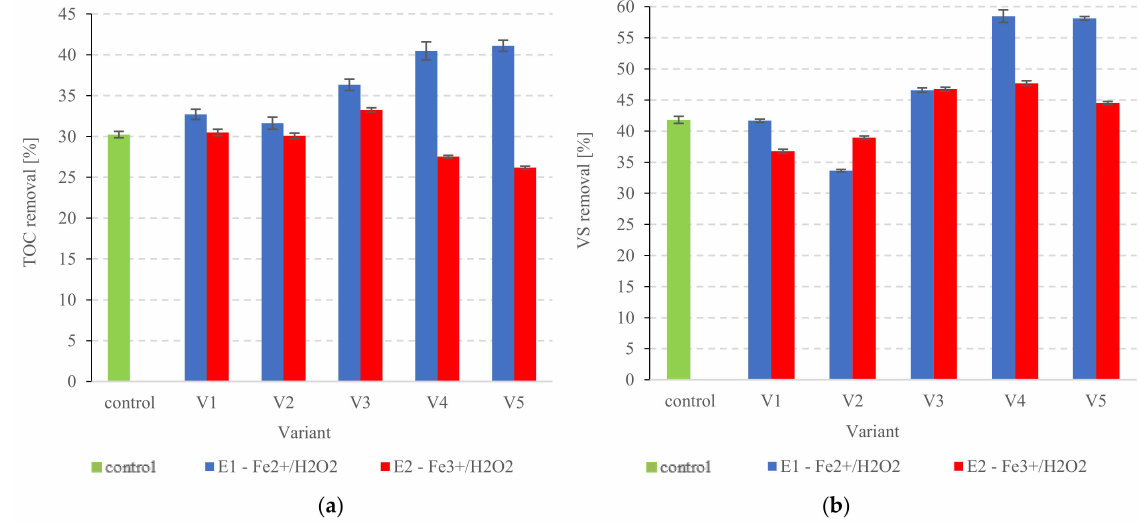
Figure 7. ( a ) TOC removal ( b ) VS removal from the PSS after pre-treatment.